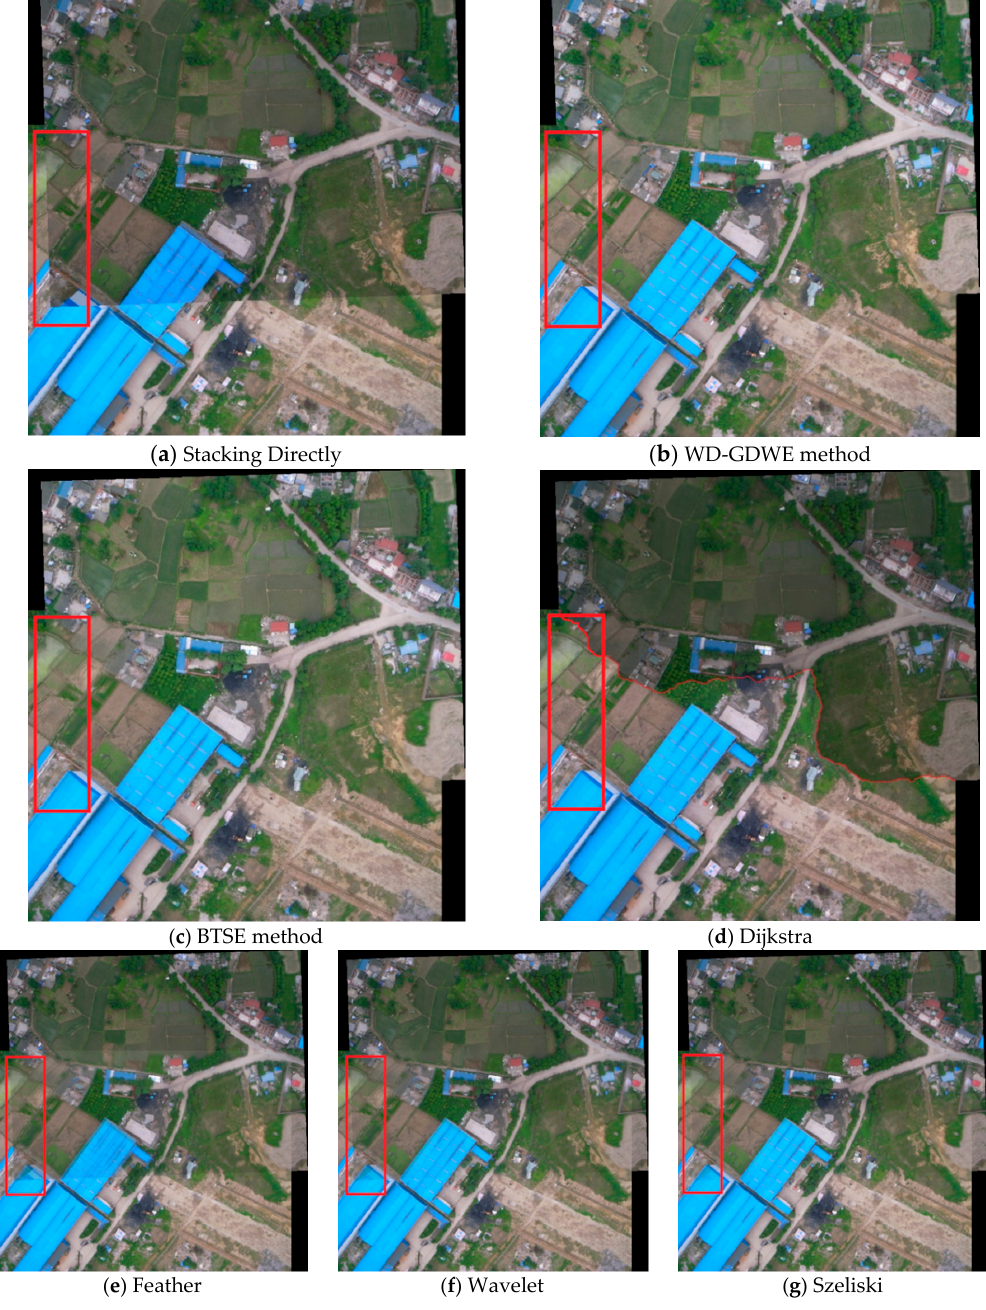
Figure 3. The performance comparison of different seam elimination algorithms.